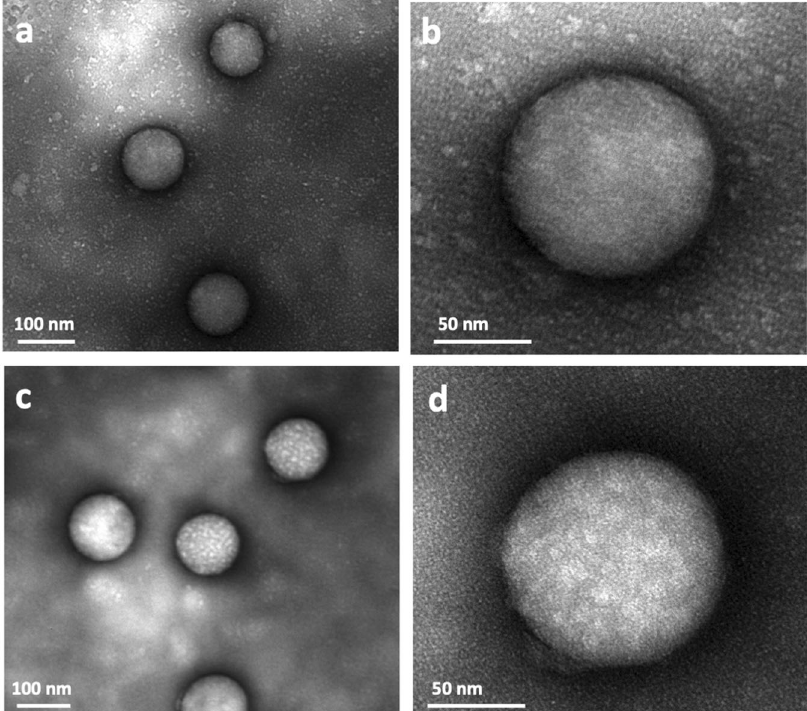
Fig. 1 TEM images of soft and hard BCs on the surface of NPs. Clusters of biomolecules are visible on both the carbon support fi lm of the Cu TEM grid and the surface of the NPs before washing ( a , b ), and in the hard corona of NPs after washing three times ( c , d ). Higher-magni fi cation images ( b , d ) of the surface of a single NP shows the clusters of biomolecules in the hard corona. Note the absence of larger clusters in the background of the unwashed sample.